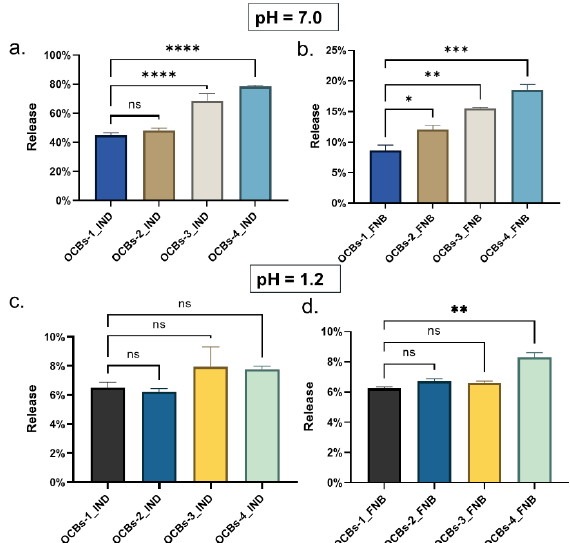
Figure 11. Comparison of the final release percentage of IND ( a ) at pH = 7.0 and ( c ) 1.2, and FNB ( b ) at pH = 7.0 and ( d ) 1.2 from four oxidized beads. ns: not significant, * p < 0.05 , ** p < 0.01, *** p < 0.001, and **** p < 0.0001.